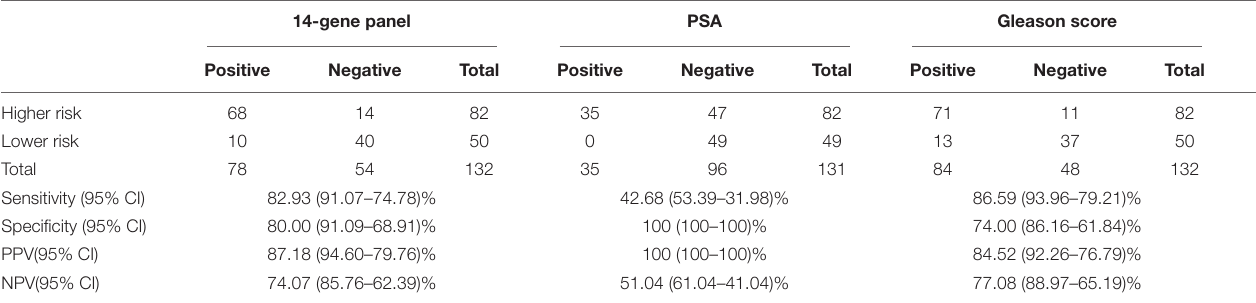
TABLE 4 | Sensitivity, specificity, PPV, and NPV of 14-Gene-Panel, PSA, and Gleason score for diagnosis of higher-risk and lower-risk PCa in Gleason scores 6 and 7 patients in a prospective PCa urine